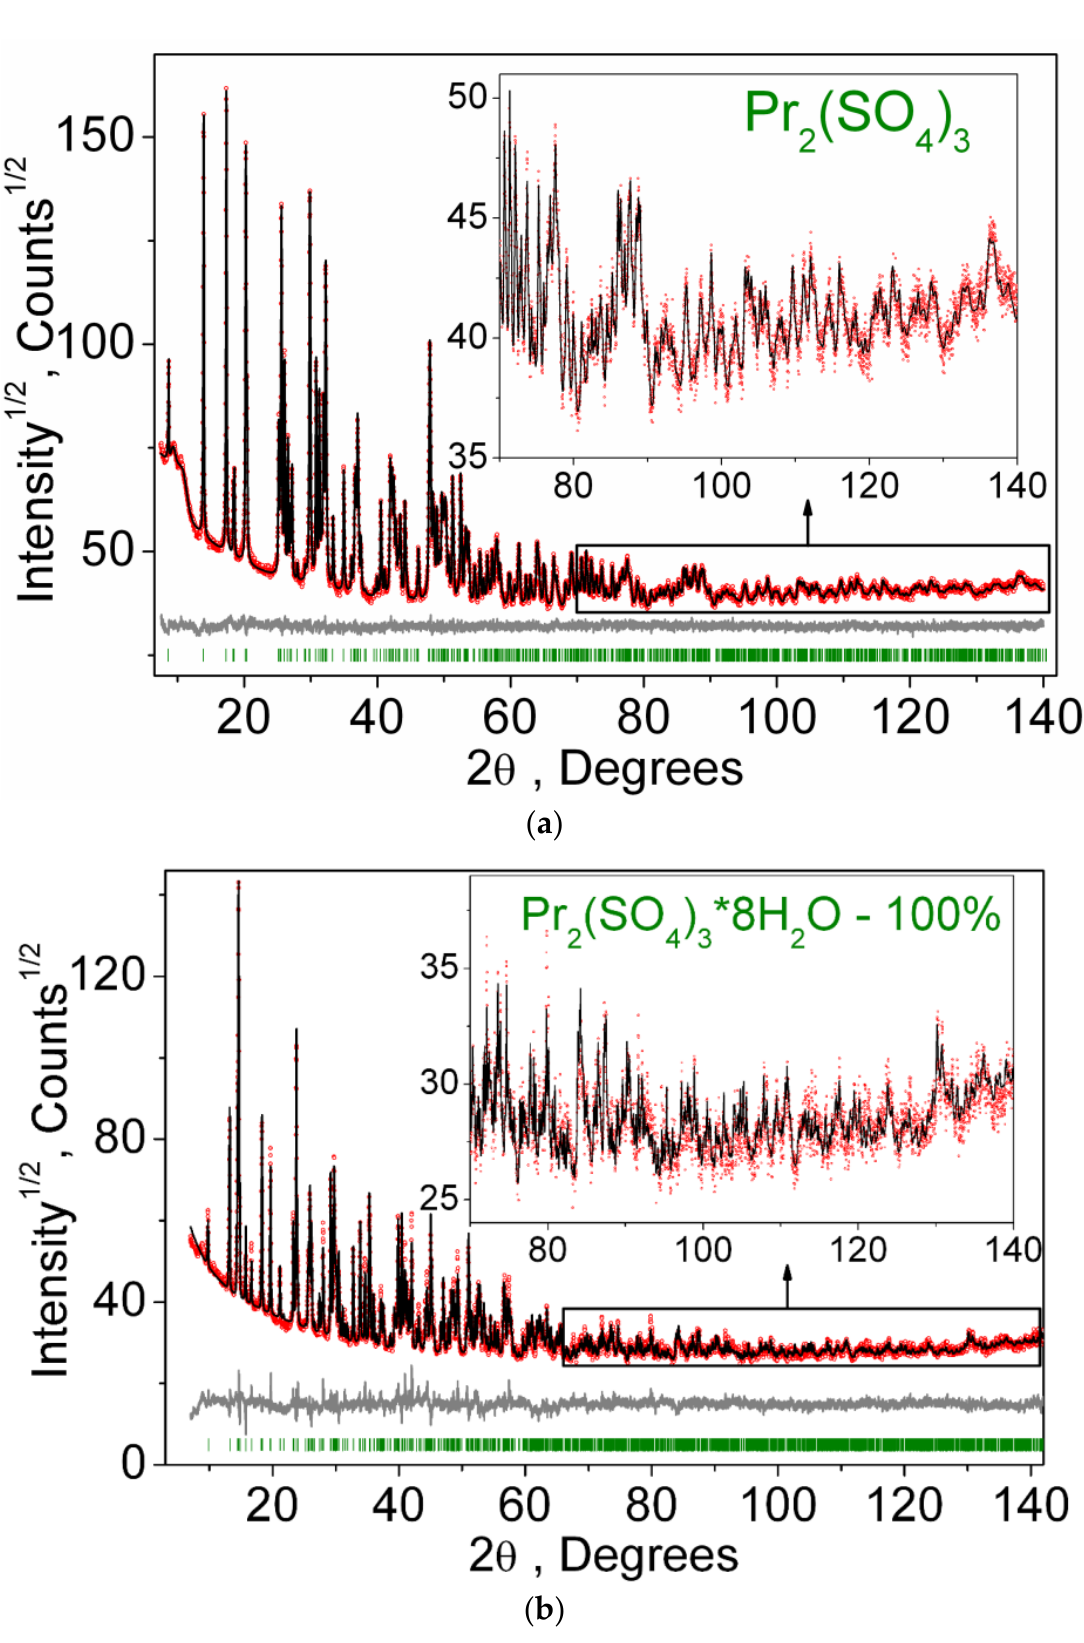
Figure 1. XRD patterns and difference Rietveld plots of ( a ) Pr 2 (SO 4 ) 3 , as obtained at 150 ◦ C, and ( b ) Pr 2 (SO 4 ) 3 · 8H 2 O.